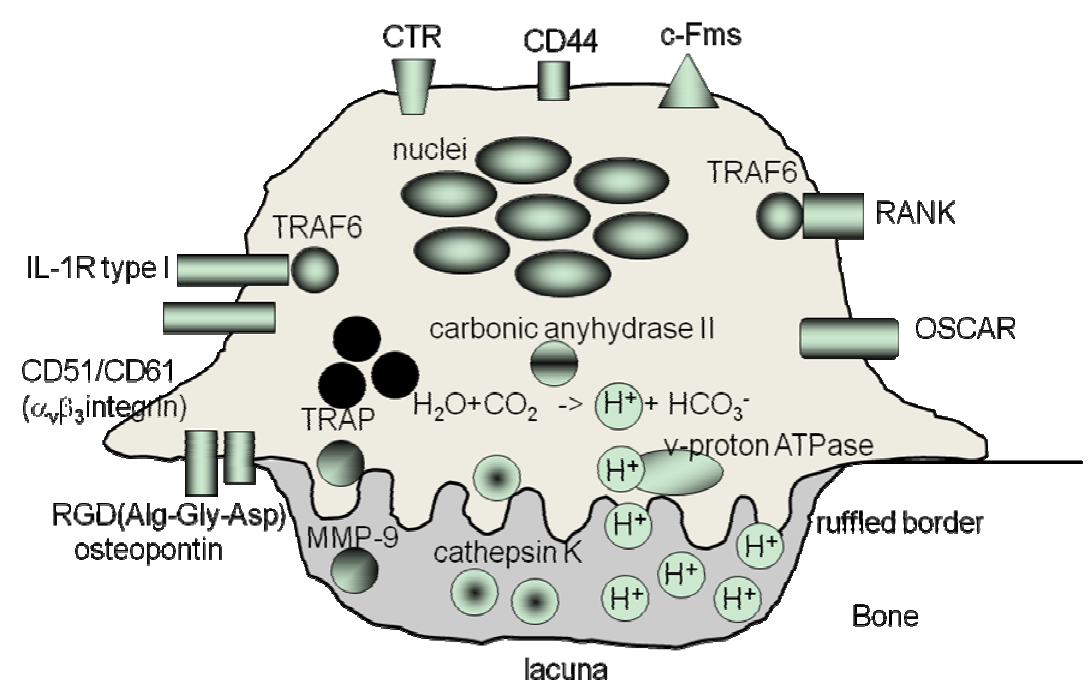
Figure 1. Schematic structure of